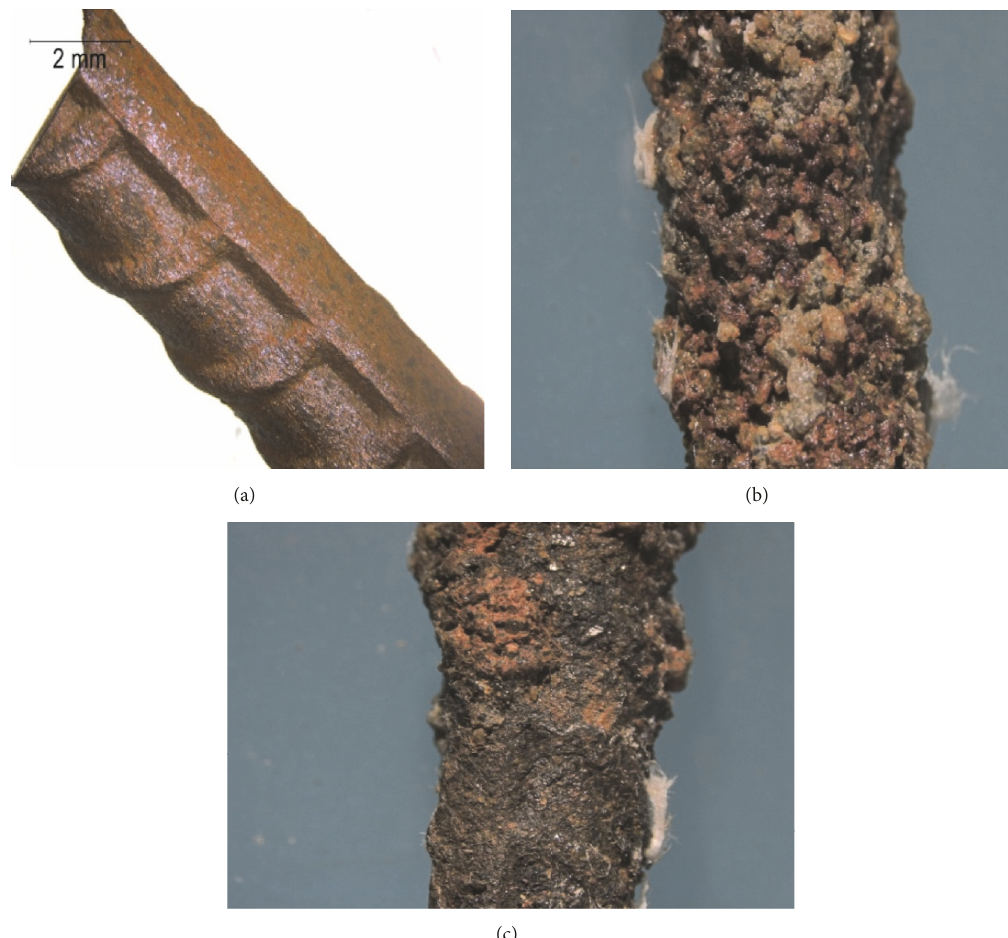
Figure 7: Optical micrographs of steel reinforcements: (a) bare, (b) in SAMPLE 1, and (c) in SAMPLE